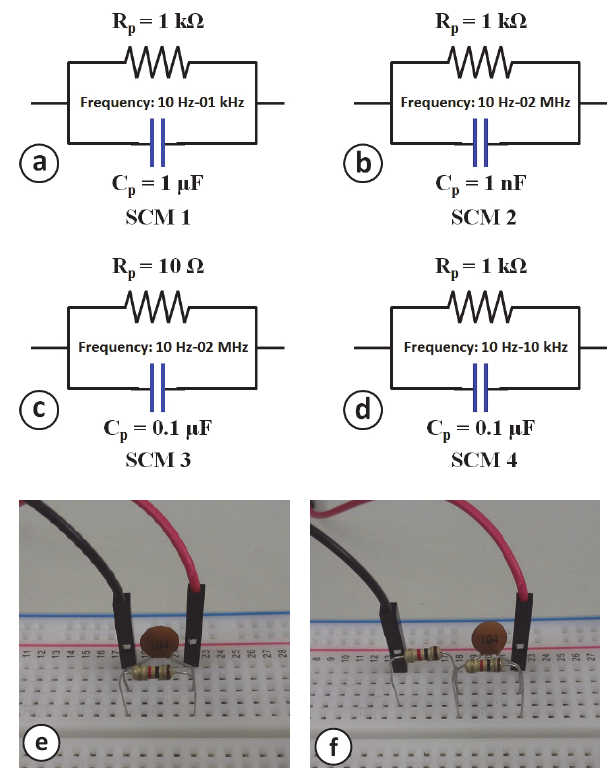
Fig.6: (a-d) Simulated circuit models developed with different electronic components and different circuit combinations of computer-simulated electrical impedance data. (e-f) Real circuit models developed with different circuit combinations of real electronic circuit components used for impedance data generation with an impedance